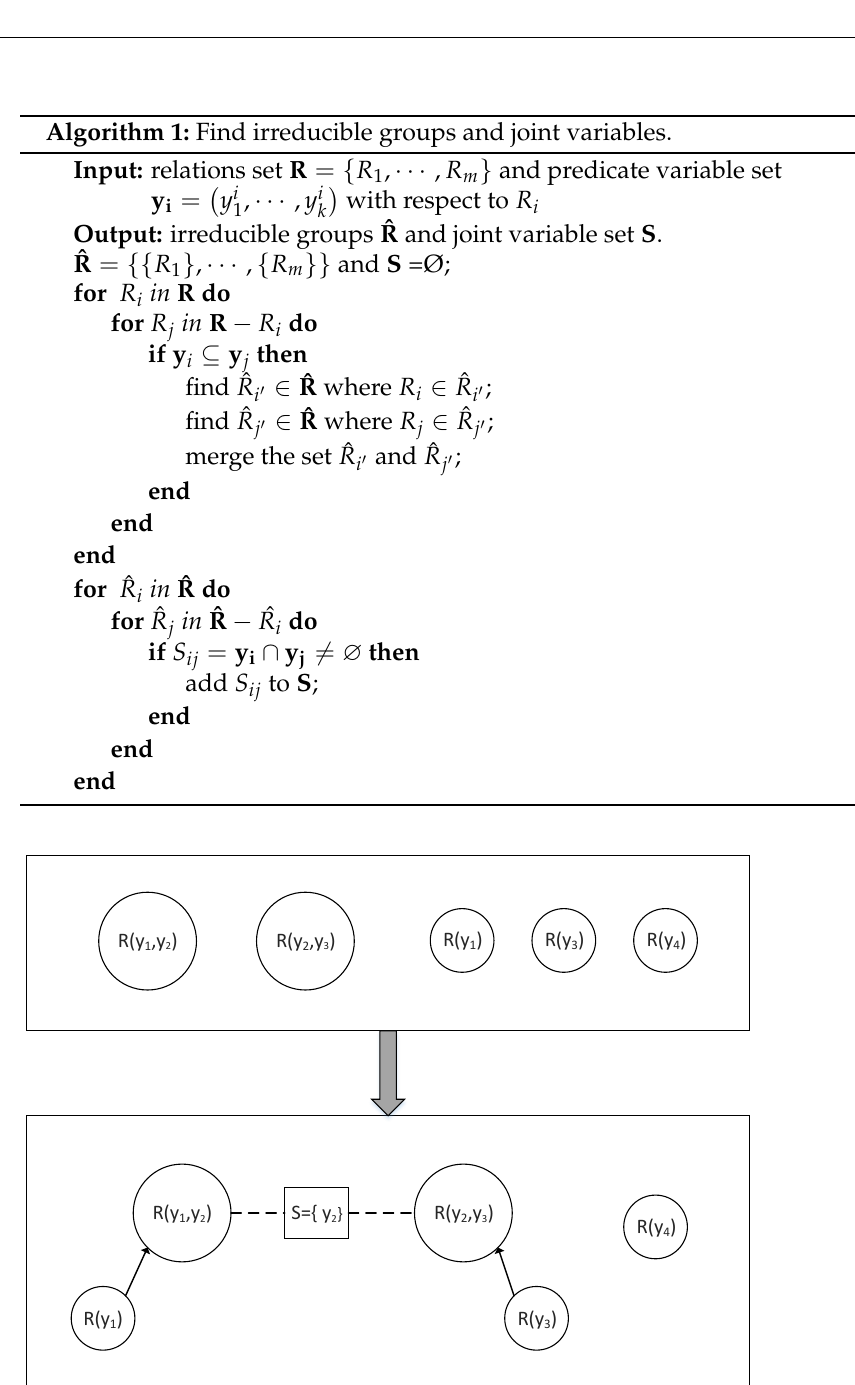
Figure 2. Example of relation